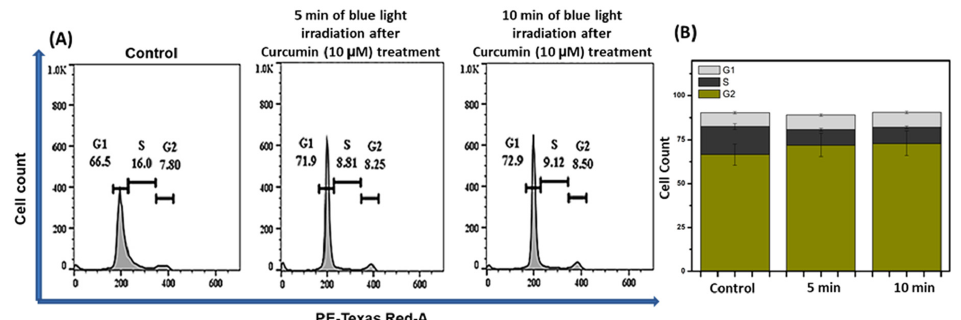
Figure 5. ( A ) Measurement of cell cycle arrest in the presence and absence of blue light (with and without Curcumin) and ( B ) cell death percentage in each step of the cell cycle (from A ). ( B ) Cell death percentage in each step of the cell cycle with statistical analysis.